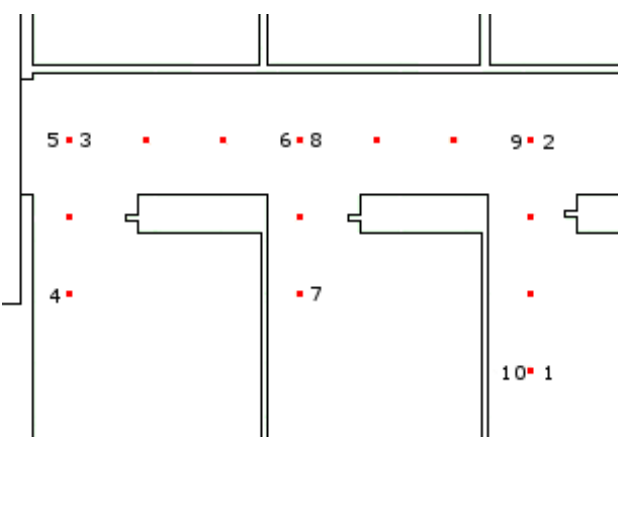
Figure 9. Model of the tracking area. The lines are walls and the squares are floor markers for each step. The numbers refer to the sequence in the test path (1 indicates beginning, and 10, ending of the path).